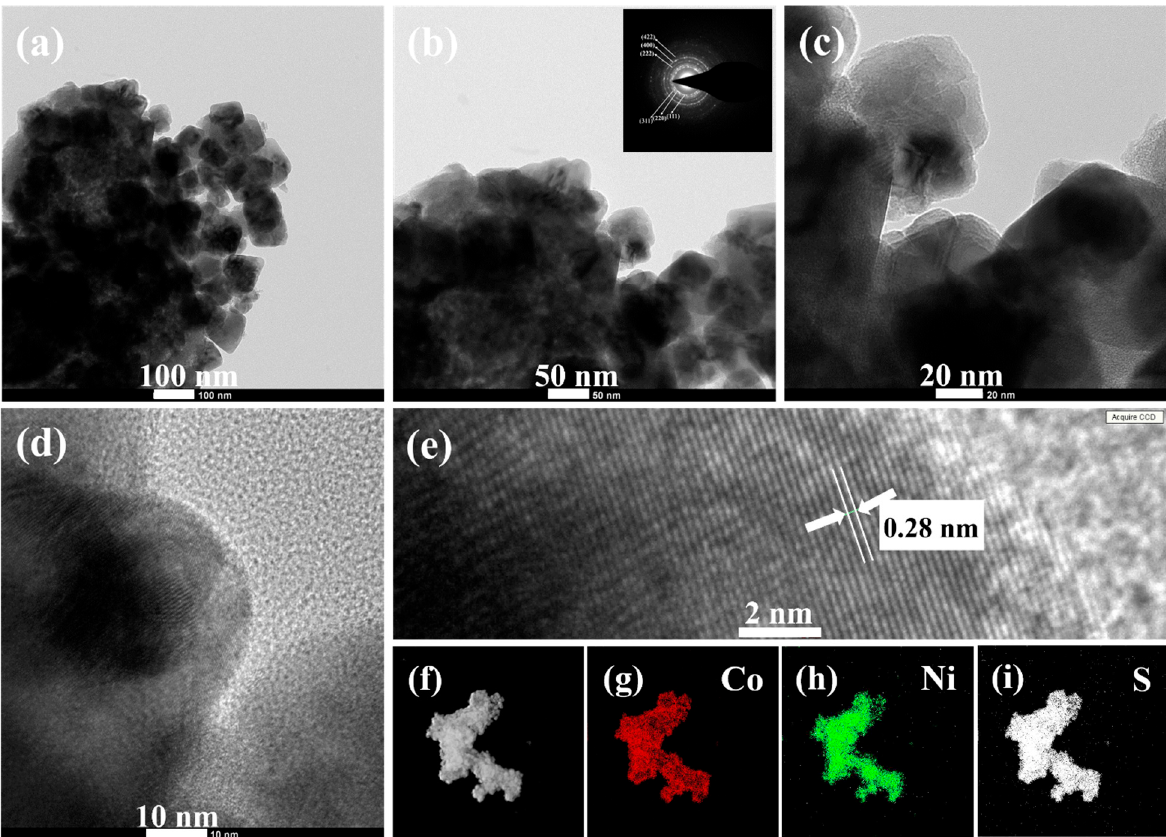
Figure 4. ( a – c ) TEM images ( d ) high magnified TEM image, ( e ) HRTEM image of CNS microsphere- like structure, and ( f – i ) HAADF-STEM elemental mapping images of CNS sample. The inset in ( b ) is the SAED pattern.